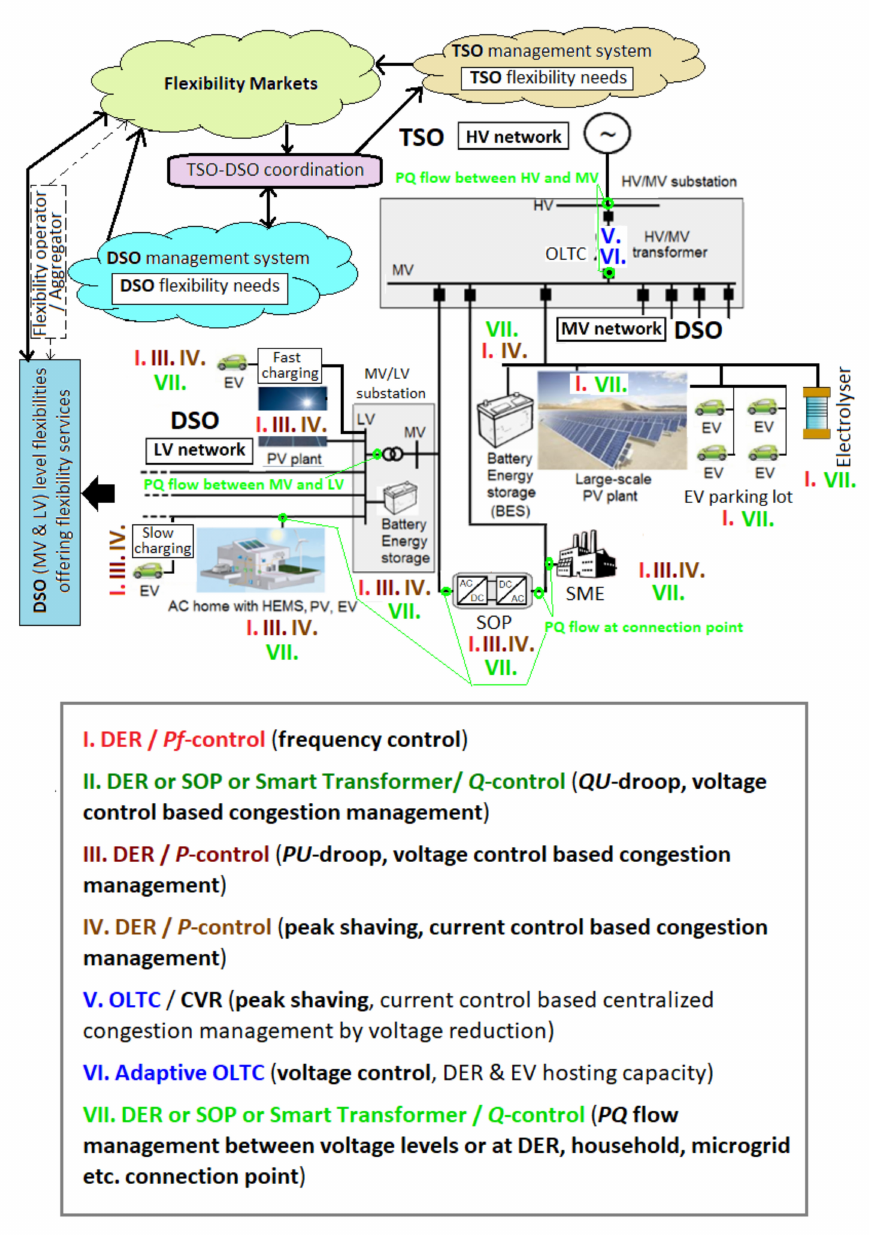
Figure 3. Future adaptive control and management methods to increase flexibility availability for provision of services (see Tables